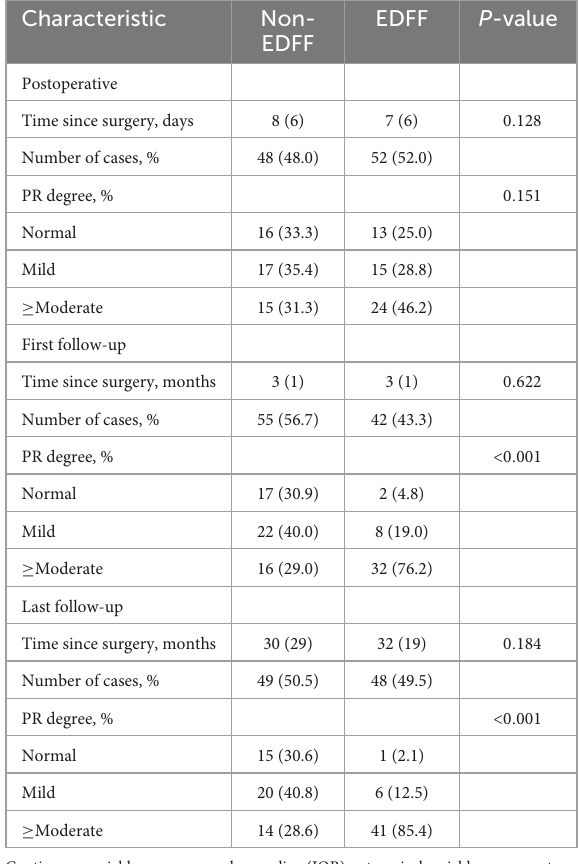
TABLE 3 Postoperative and follow-up